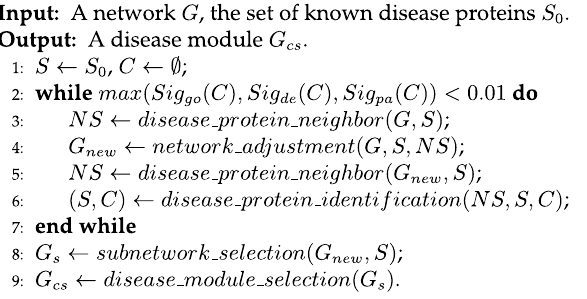
Algorithm 1. Framework of the IDMCS.